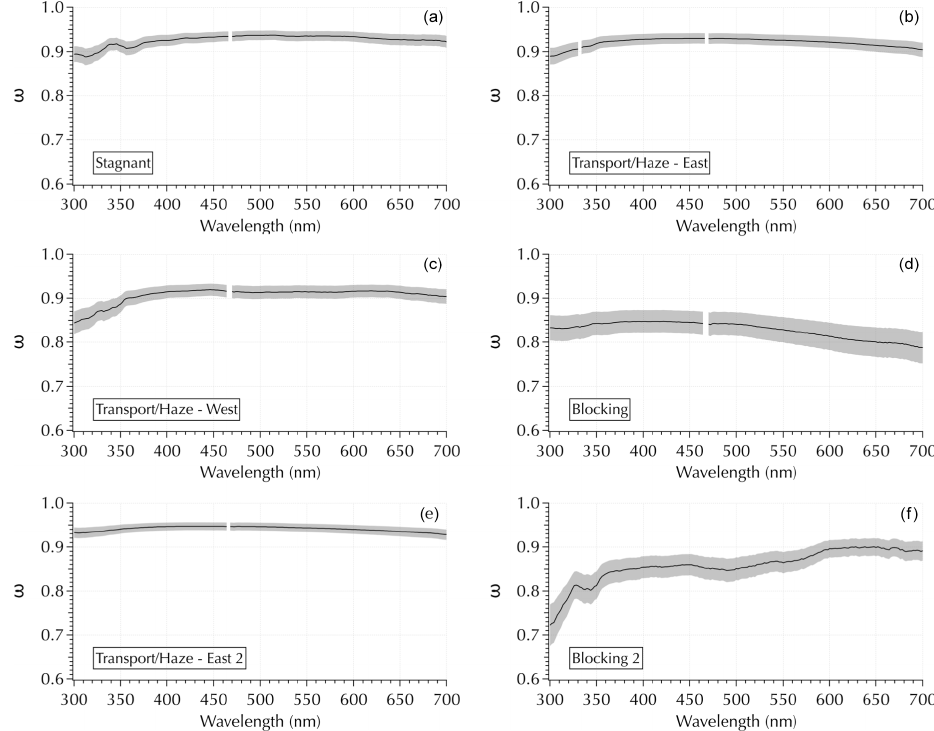
Figure 10. Examples of variability in ω spectra using the same four examples as in Fig. 2 (a–d) , plus an additional example from downwind Transport/Haze and Blocking ( e, f ,